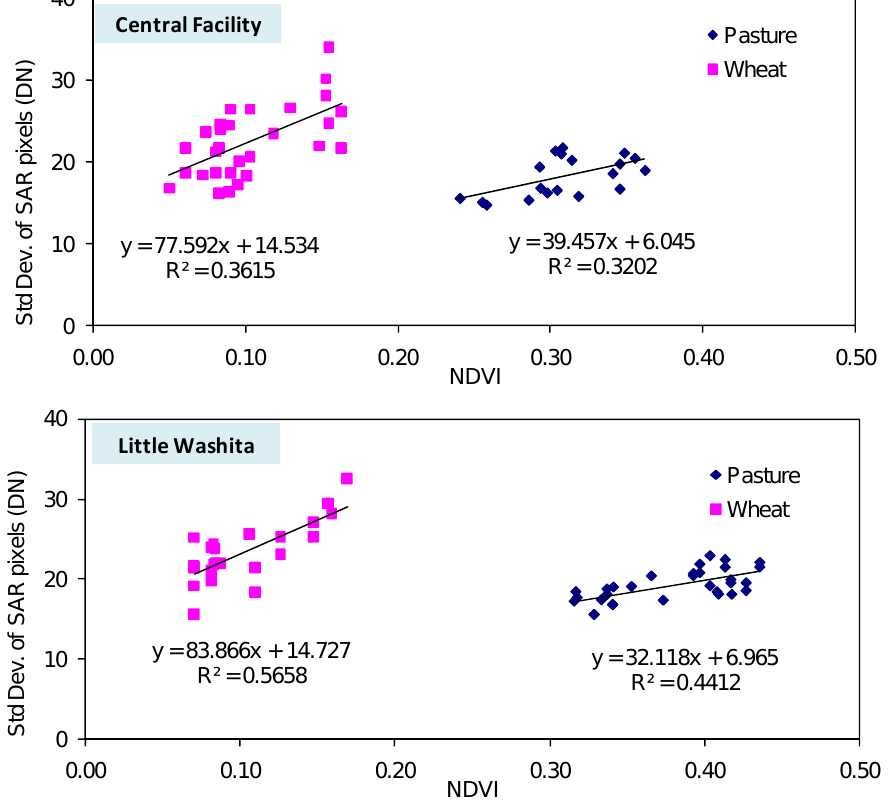
Figure 7. Relationship between NDVI and Sub-pixel variability of SAR backscatter (DN) measured as a standard deviation within the ESTAR footprint (800 m) size for homogeneous Wheat and Pasture/rangeland for Area Central Facility and Little